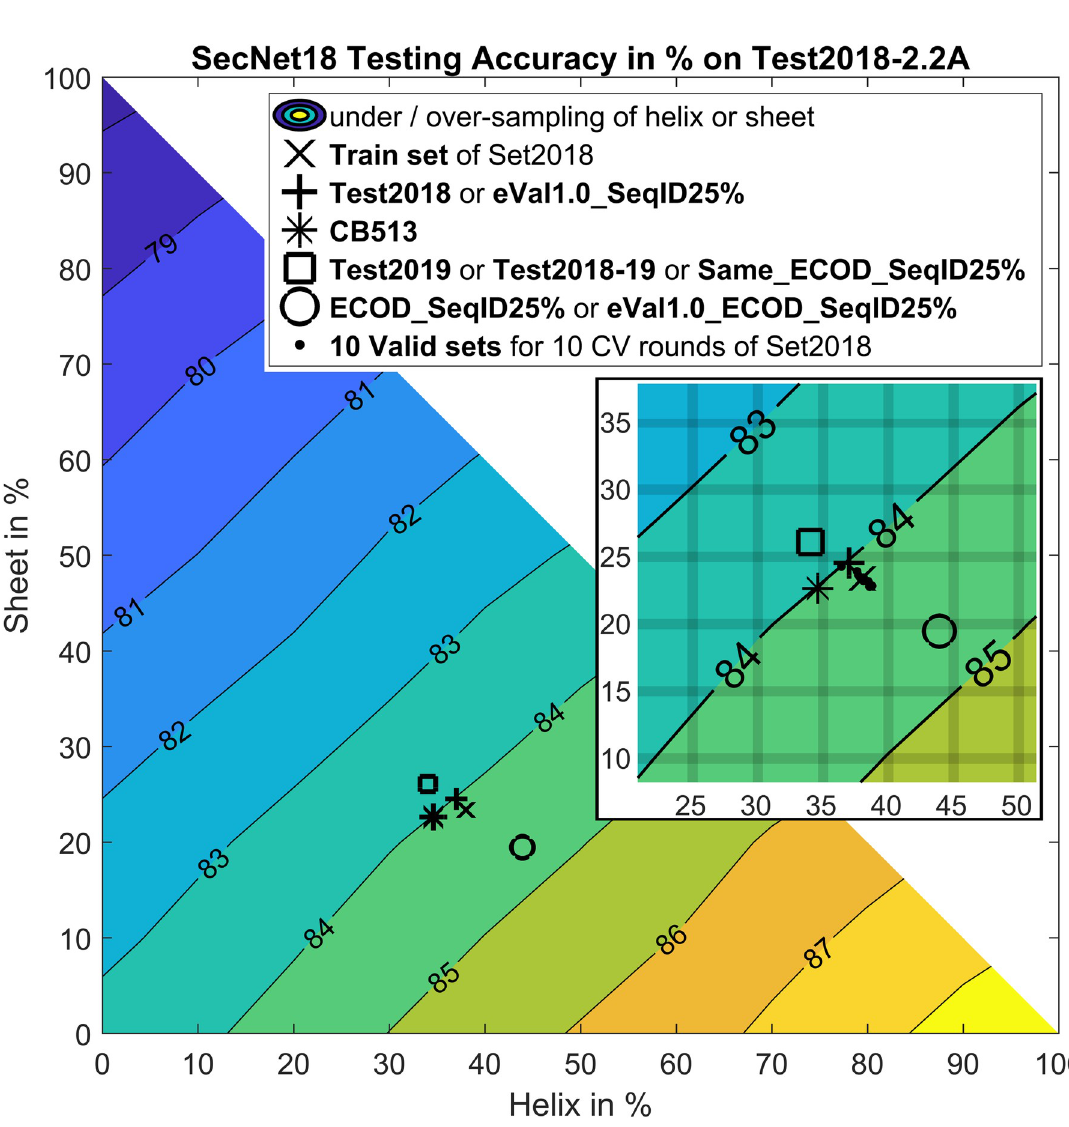
Fig 3. Variation of 3-label Rule #1 accuracy as a function of proportions of helix ( H% ), sheet ( E% ) and coil ( C% = 100%– H% – E% ) in Test2018 test set. The Rule #1 accuracy of SecNet on Test2018 test set is 84.0% and shown with ‘+’. The contour plot demonstrates how SecNet prediction accuracy can be skewed if a test set is enriched or diluted with helix and/or sheet. For example, if the underlying test set has 100% helices, the accuracy rises to 88.7% (bottom right). If it is 100% sheet, the accuracy drops to 77.6% (top left). If it is 100% coil, the accuracy is 83.4% (bottom left). The extrapolated SecNet accuracies are indicated for the label proportions of Set2018 training set with ‘x’, CB513 test set with ‘ � ’ and ten validation sets for each cross-validation round of Set2018 with ten ‘.’. eVal1 . 0_SeqID25% has label frequencies almost identical to Test2018 and shares ‘+’. For the same reason Test2019 , Test2018-19 and Same_ECOD_SeqID25% share ‘ □ ’ while ECOD_SeqID25% and eVal1 . 0_ECOD_SeqID25% are shown with ‘o’. The differences in extrapolated accuracies of these sets call for adjustment of the actual accuracies (“Raw values” in Table 9) to the accuracies with the same label proportions (“Adj. to Test2018” in Table